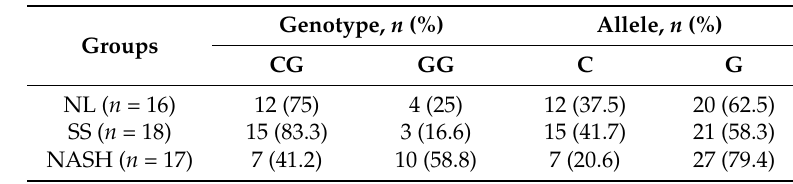
Table 3. The distribution of rs738409 polymorphism in morbidly obese women according to liver